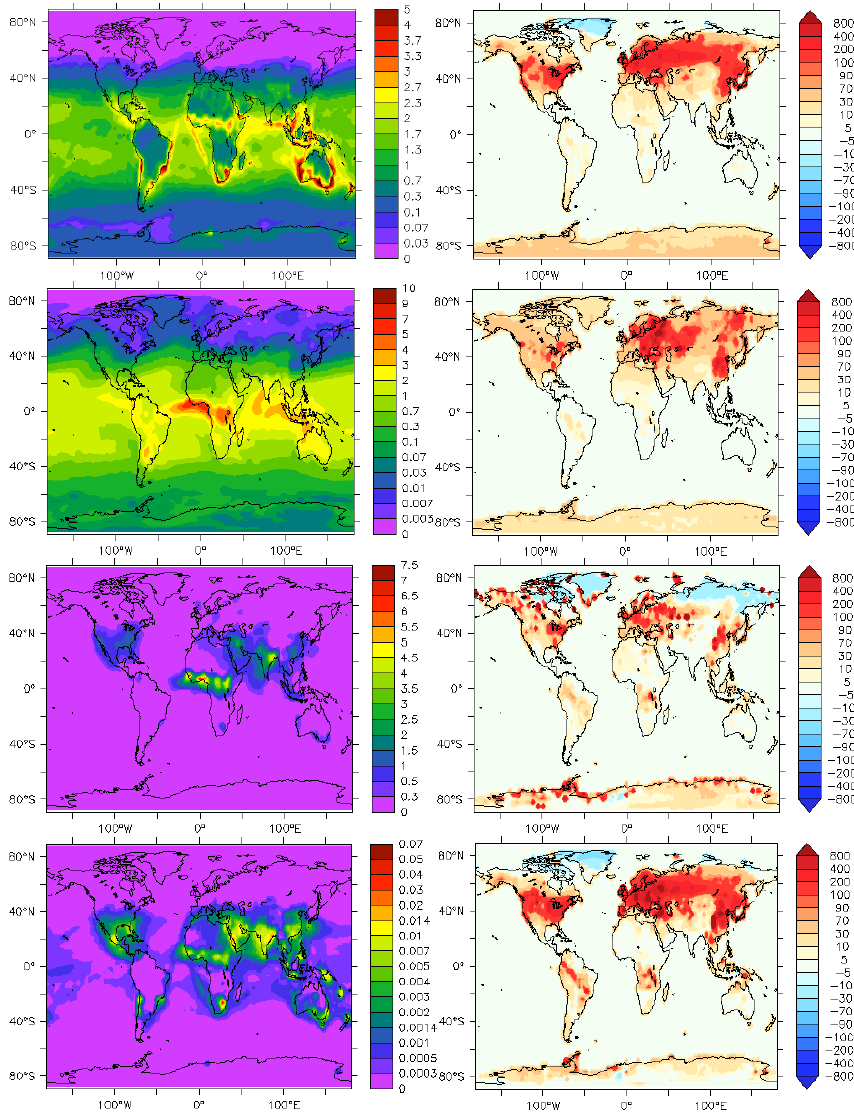
Fig. 2. Average simulated OH (from top to bottom) (10 6 molecules cm − 3 ), H 2 O 2 , HNO 3 , H 2 SO 4 (ppbv) near the surface from the reference run (base_S1, left panels) and their relative enhancements (%) due to the implementation of realistic HONO levels in the model (S1, right panels) in